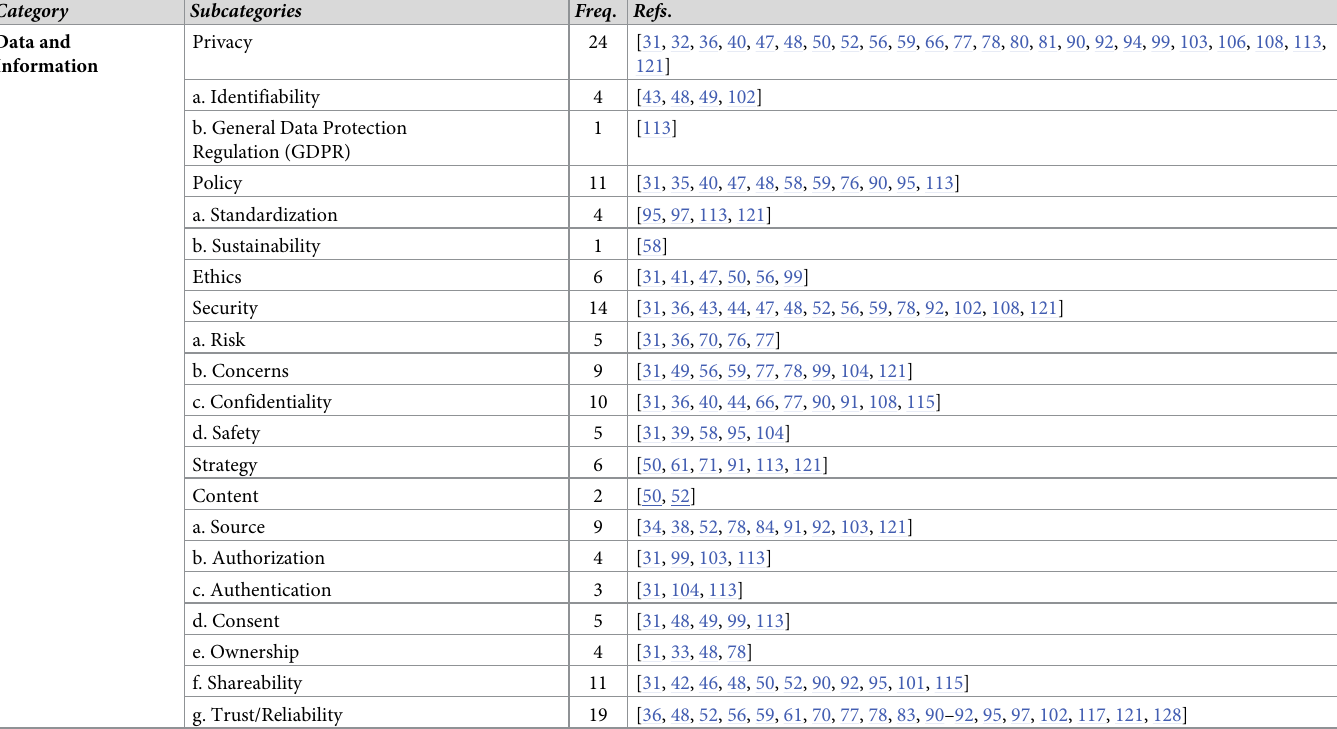
Table 9. Summary of findings in the reviewed literature: Data and